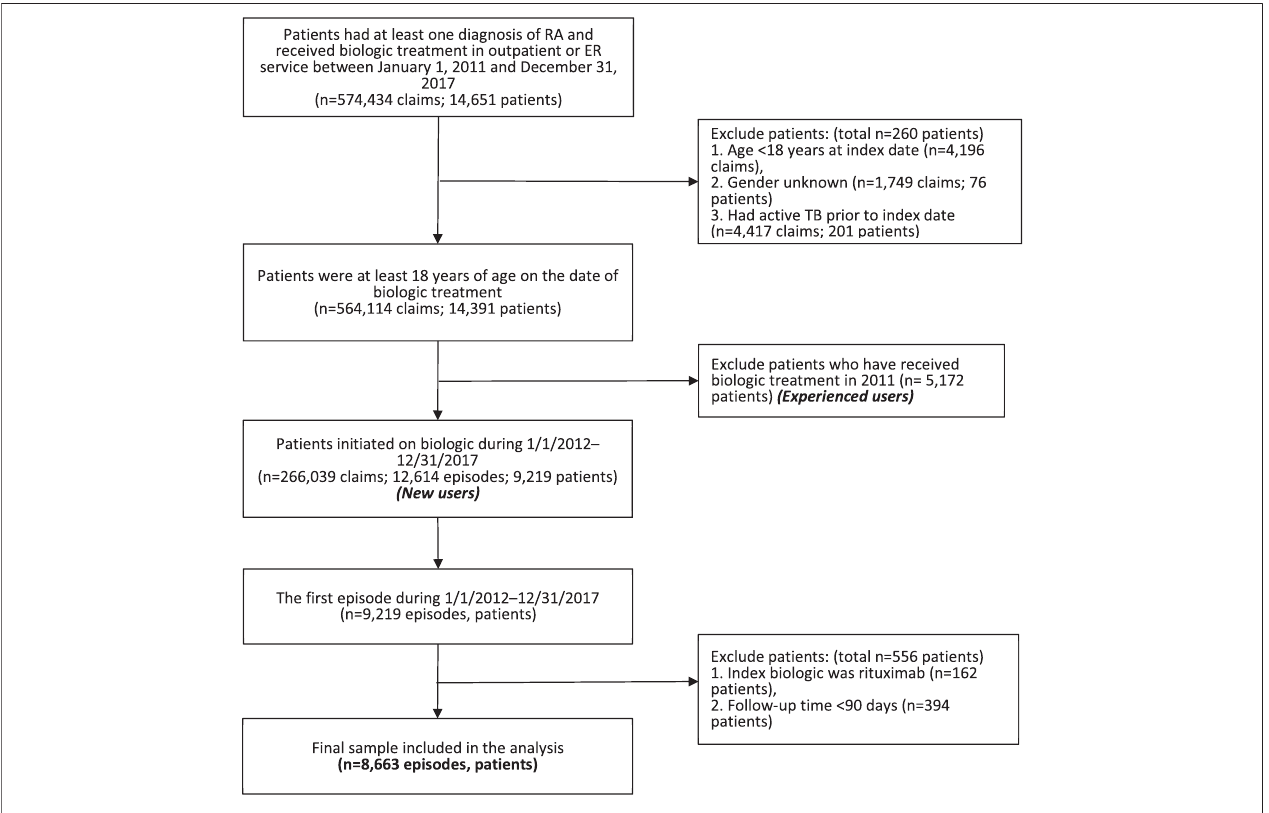
FIGURE 1 | Flow chart of patient selection. Abbreviation: ER, emergency room; RA, rheumatoid arthritis; TB, tuberculosis.